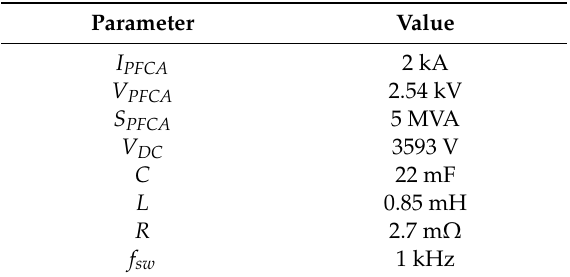
Table 1. Rated values of each PFCA cell.